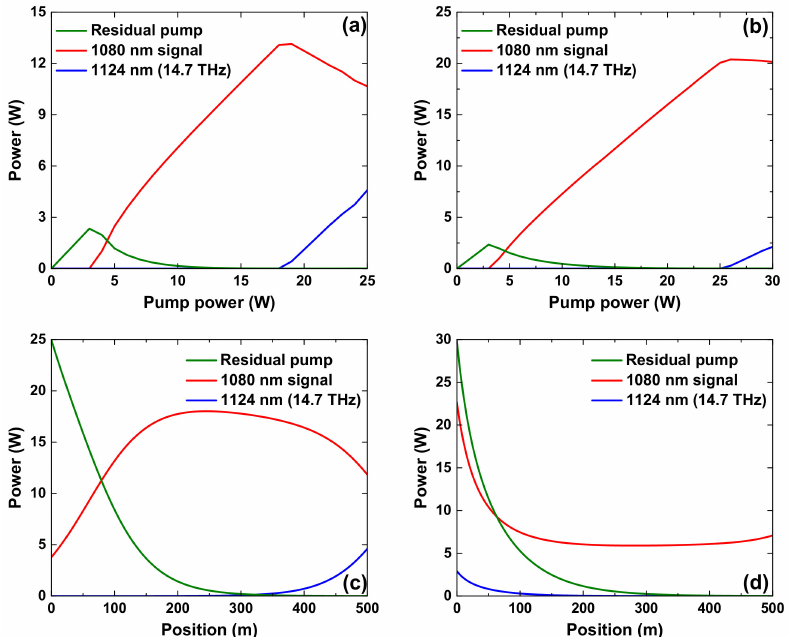
Figure 1. The power evolution characteristics of ( a ) forward-pumped low-quantum defect Raman fiber laser and ( b ) backward-pumped low-quantum defect Raman fiber laser; The power distribution characteristics of ( c ) forward-pumped low-quantum defect Raman fiber laser and ( d ) backward- pumped low-quantum defect Raman fiber